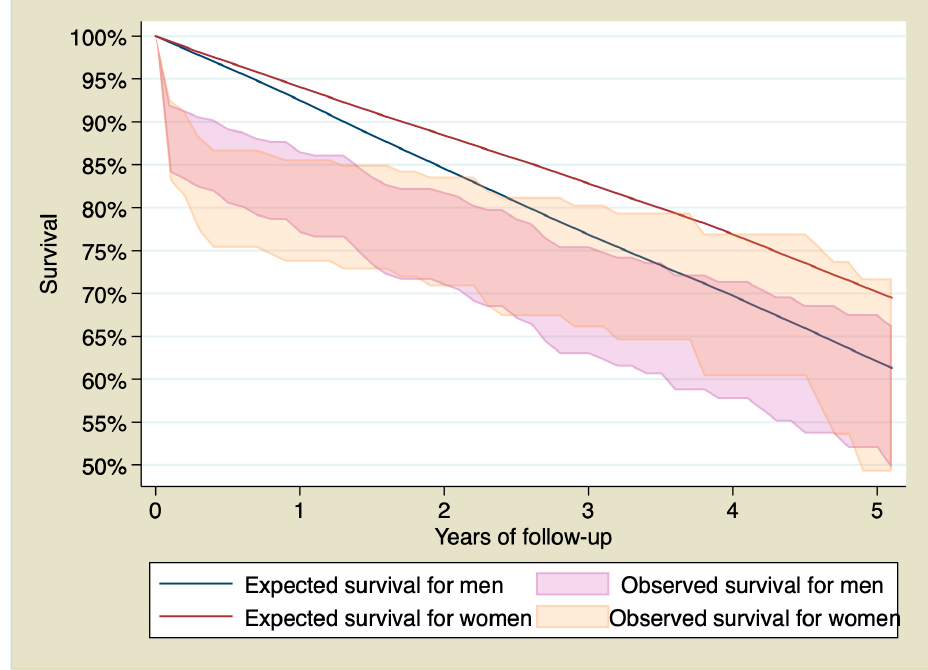
Figure 2. 95% confidence interval of the observed survival compared with the expected survival of the sample stratified by sex.